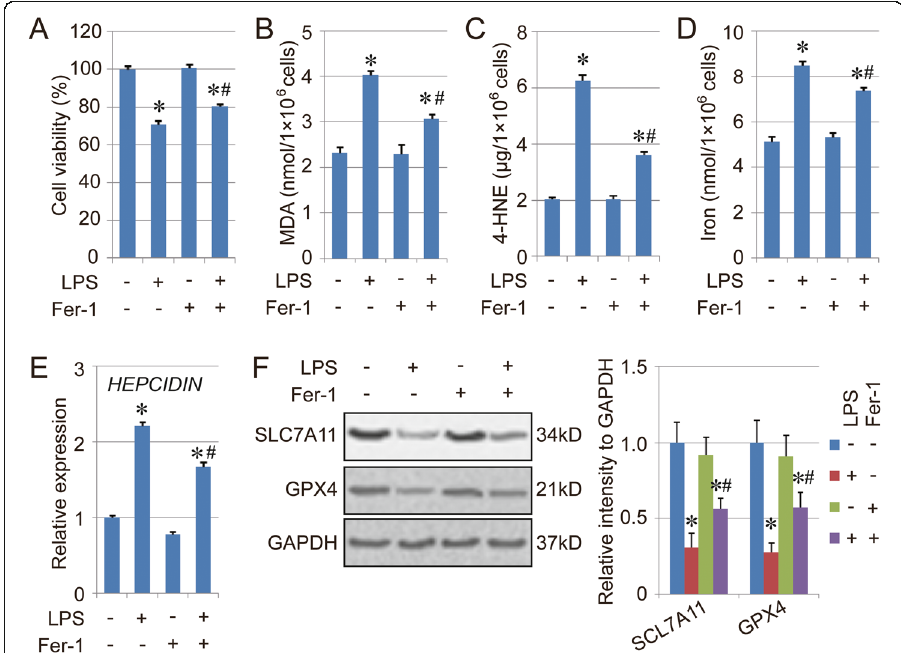
Fig. 3 Effect of Fer-1 on LPS-induced cell injury in an air-liquid interface. a . Cell viability of BEAS-2B cells in an air-liquid interface treated with LPS and Fer-1. The cells were treated with LPS (10 mg/L) and Fer-1 (2 μ M) for 16 h, then the cell viability of each group was measured using CCK-8. b - d . Levels of MDA (B), 4- HNE (C) and total iron (D) in the BESA-2B cells treated with LPS. e . mRNA expression of HEPCIDIN . f . Protein levels of SLC7A11 and GPX4 in the BESA-2B cells treated with LPS in an air-liquid interface. Results are expressed as means±SEM ( n = 3). *: p < 0.05 compared with the control group. #: p < 0.05 compared with the LPS